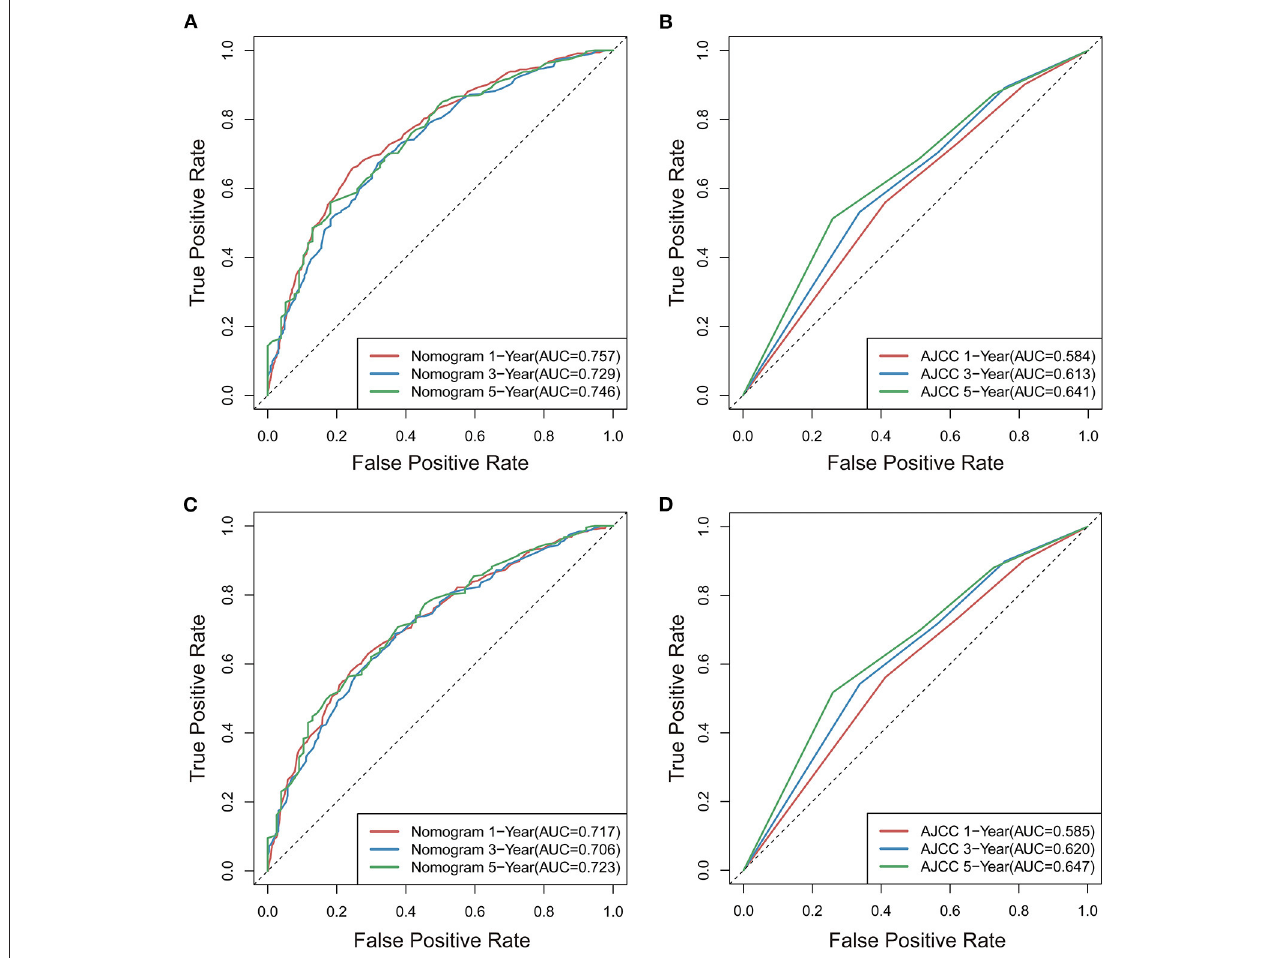
FIGURE 10 | Comparison of ROC curves for predicting patients’ OS at 1, 3, and 5years between novel nomogram (A) and AJCC model (B) , for predicting patients’ CSS at 1, 3, and 5years between novel nomogram (C) and AJCC model (D)